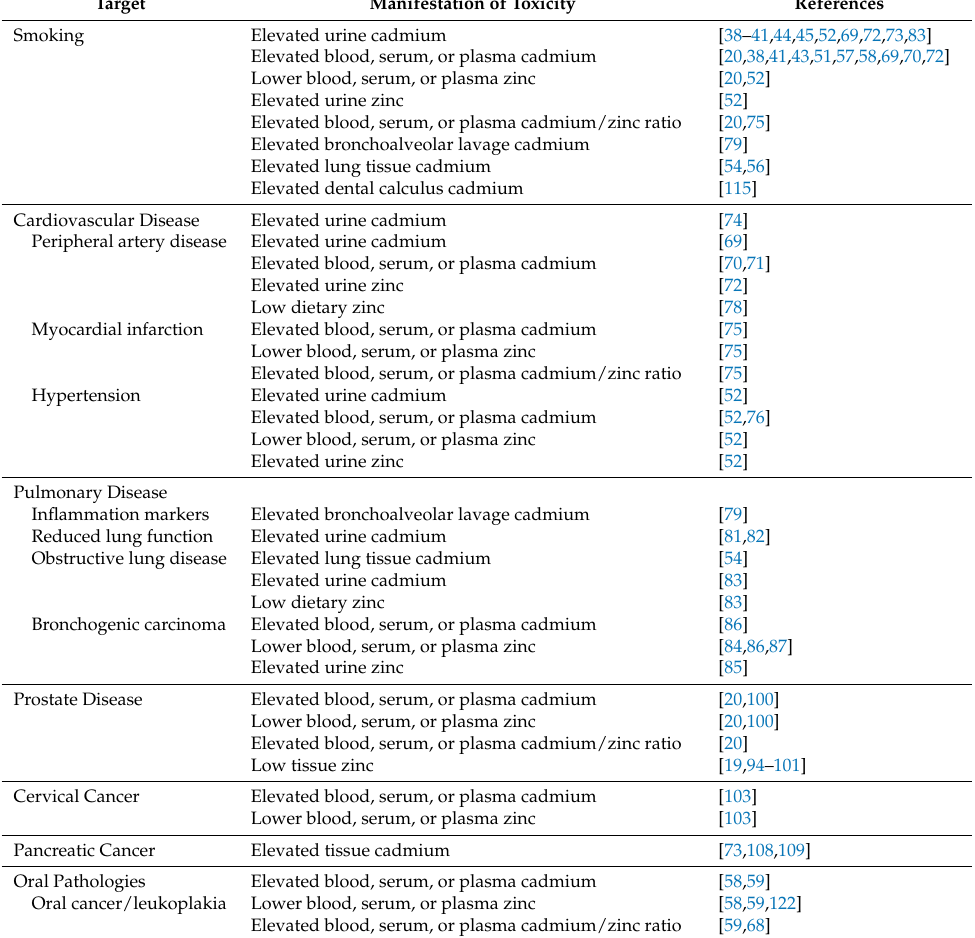
Table 1. Tobacco-related disease and evidence of cadmium and zinc